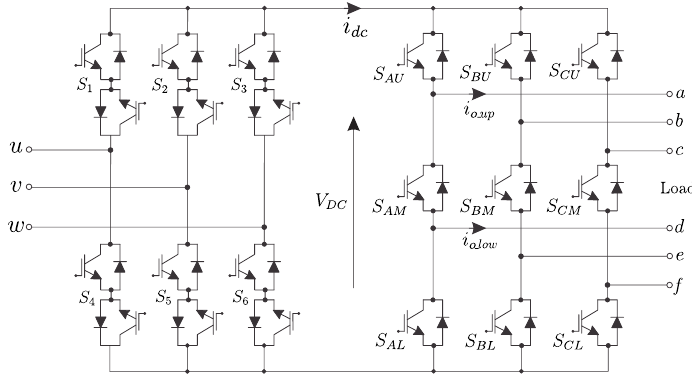
Figure 28. Indirect matrix converter with dual output.